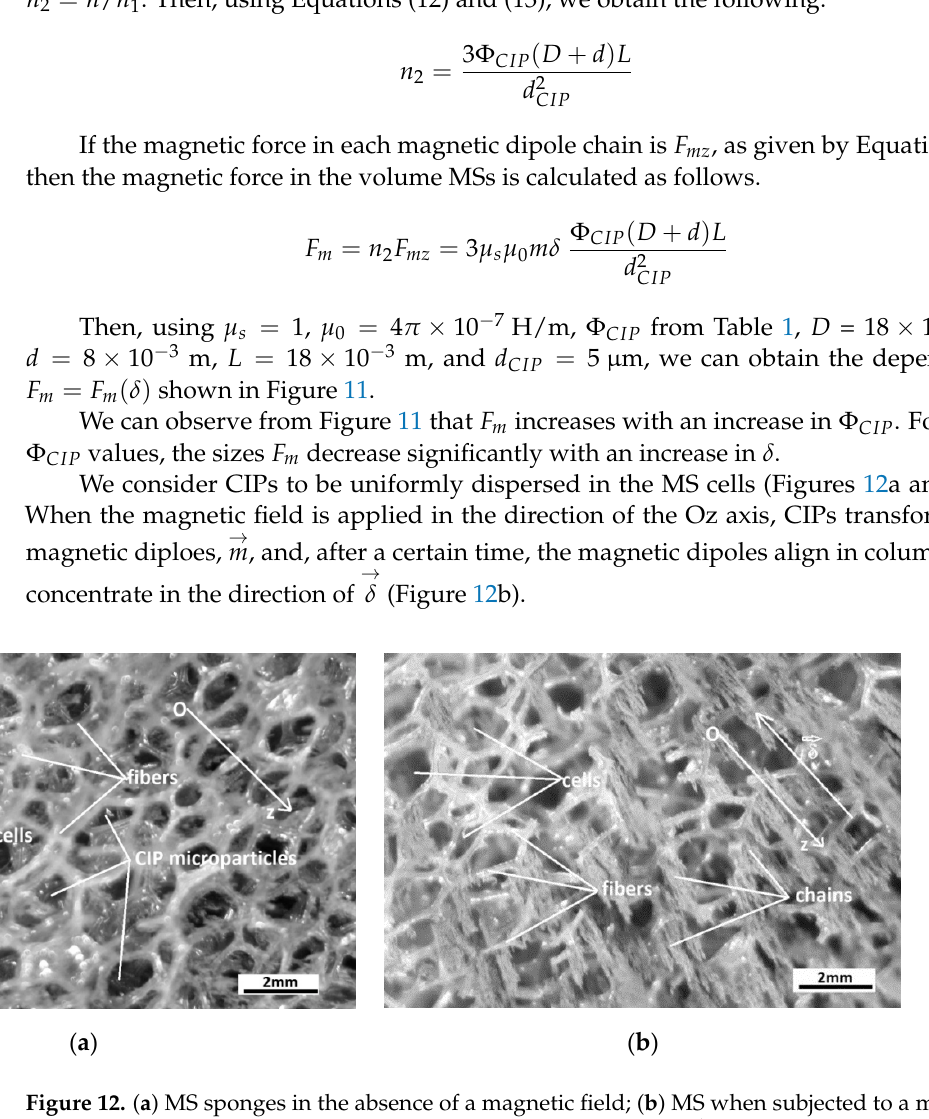
→ δ is the vector of magnetic field